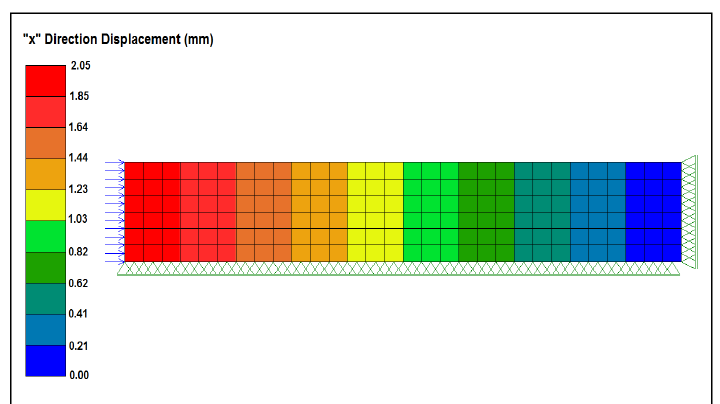
Figure 6. Field of axial displacement at the instant of loading – Case 1.